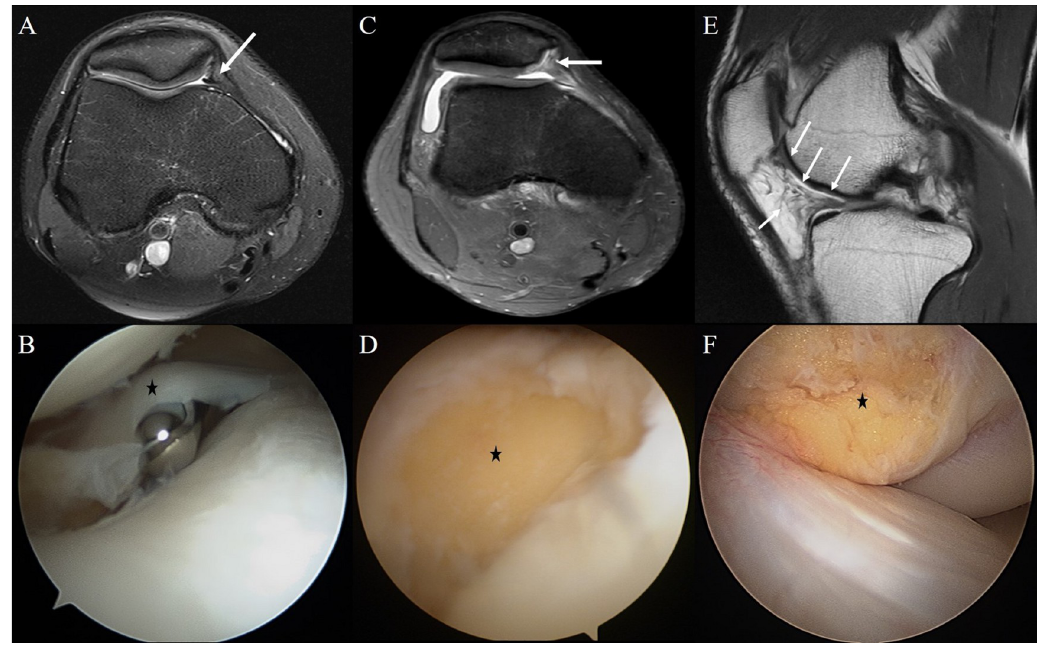
Fig 2. Knee MRI and arthroscopic findings of patients in study group. (a, b) A 21-year-old man with medial patellar plica (MPP) syndrome showed thickened MPP (arrow) and impingement MPP (asterisk) between medial femoral condyle and patella. On MRI, the PPTA was 138.2˚. (c, d) A 22-year-old man with chondromalacia patella showed contour defects in the cartilage surface of patella medial facet (arrow) and there was 1.5 × 1.5 cm sized cartilage defect (asterisk) in that area on arthroscopy. The PPTA was 138.0˚ in this patient. (e, f) A 21-year-old man with infrapatellar fat pad (IPFP) syndrome showed soft tissue infiltrations (arrows) at IPFP on MRI and fat tissue hypertrophy (asterisk) on arthroscopy. The PPTA was